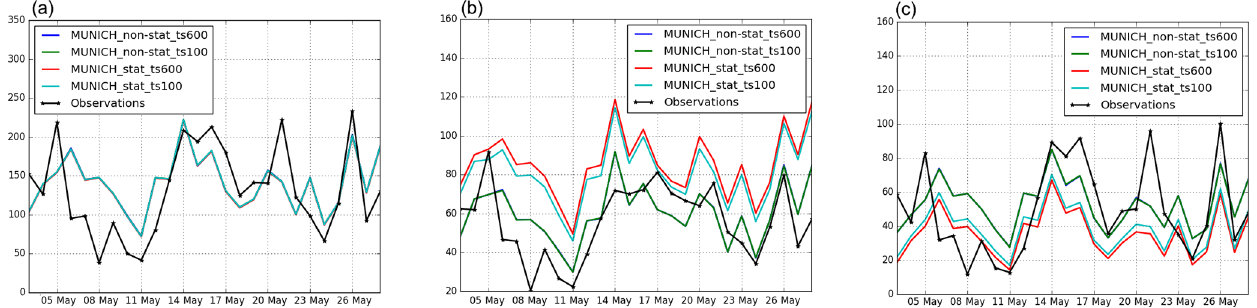
Figure 7. Daily average concentrations of NO x (a) , NO 2 (b) and NO (c) concentrations (µgm − 3 ) calculated by MUNICH at CELES station with different main time steps using the stationary and nonstationary approaches.